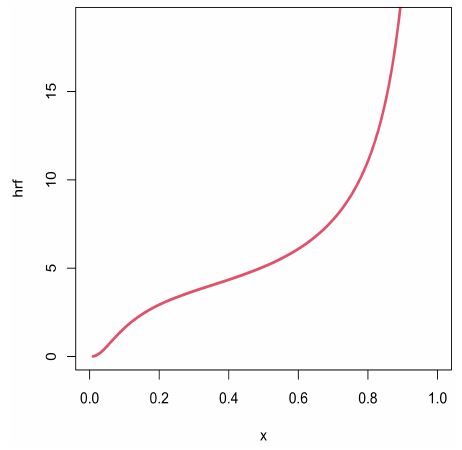
Figure 11. Plots of the estimated hrfs for the times of infection data set.